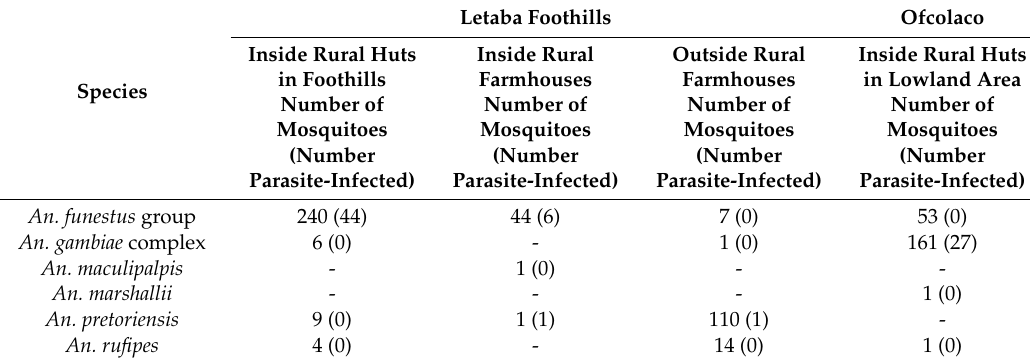
Table 3. Parasite infections in Anopheles surveyed in the “Transvaal” in 1931 by Swellengrebel et al. [2]. Letaba Species